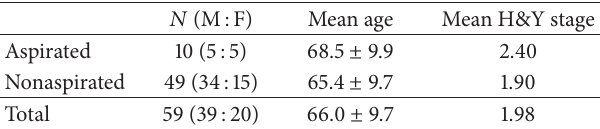
Table 2: Results of the videofluoroscopic swallowing study in patients with Parkinson’s